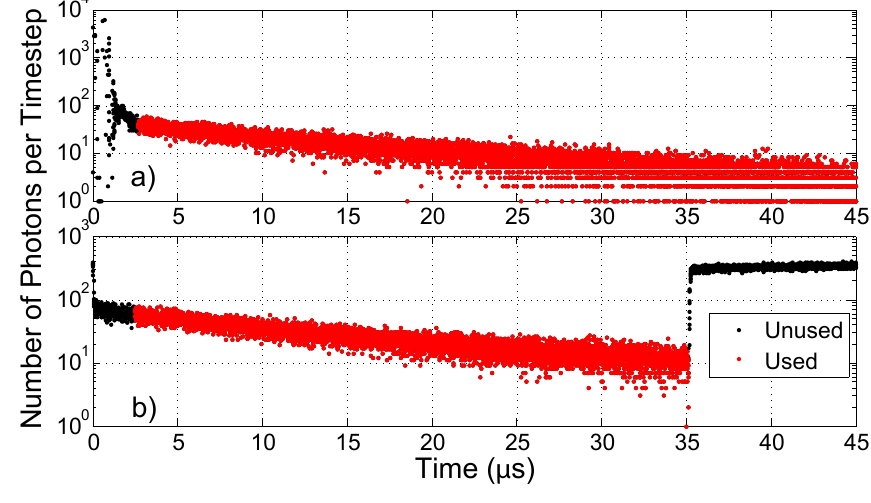
Fig. 2. Timestep in y-axis label corresponds to temporal resolution of Alazar data acquisition card (5.55 ns). (a) Example histogram corresponding to 1000pptv glyoxal collected with Ti:Sapphire laser in 5min. The initial large peak is the laser pulse. (b) Example histogram corresponding to 4200pptv glyoxal collected with CrystaLaser in 15 min. Both the initial peak as well as the plateau after the used data results from laser